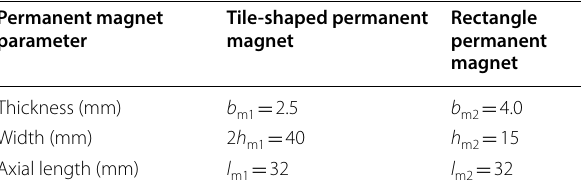
Table 1 Size of permanent magnet